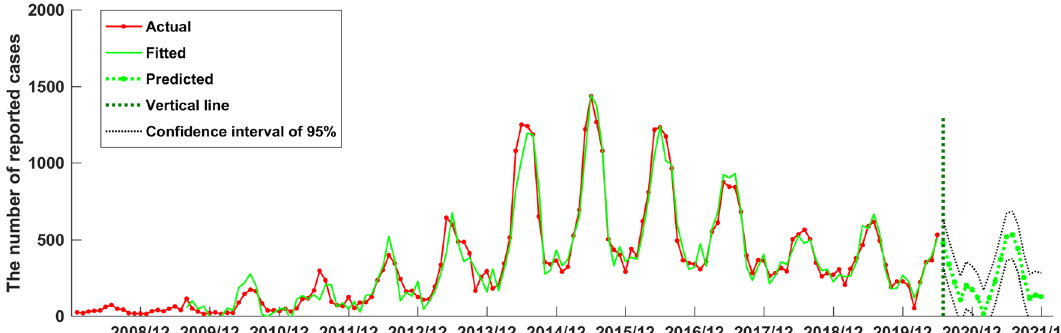
Figure 9. The SARIMA((1,4,5,7),0,0)(0,1,2) 12 model fitted and forecasted time series of reported cases of human brucellosis in